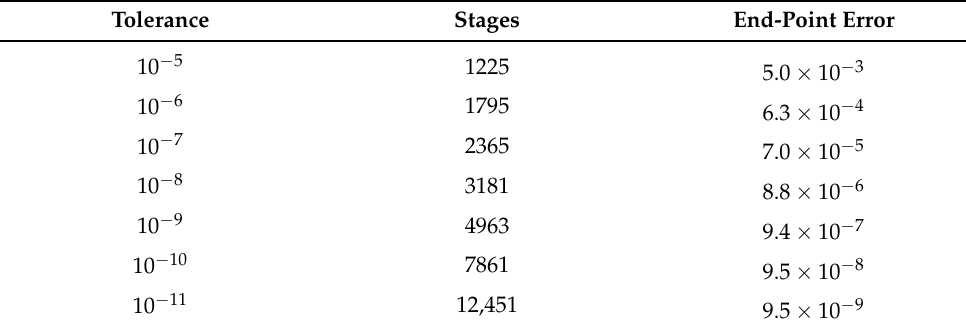
Table 2. Results of T5(4) over Kepler orbit for γ = 0.6.